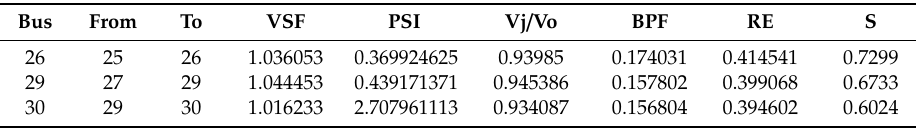
Table 5. The obtained indices’ magnitude for three weakest buses identification by each index (IEEE 30-bus system). Bus From To VSF PSI Vj / Vo